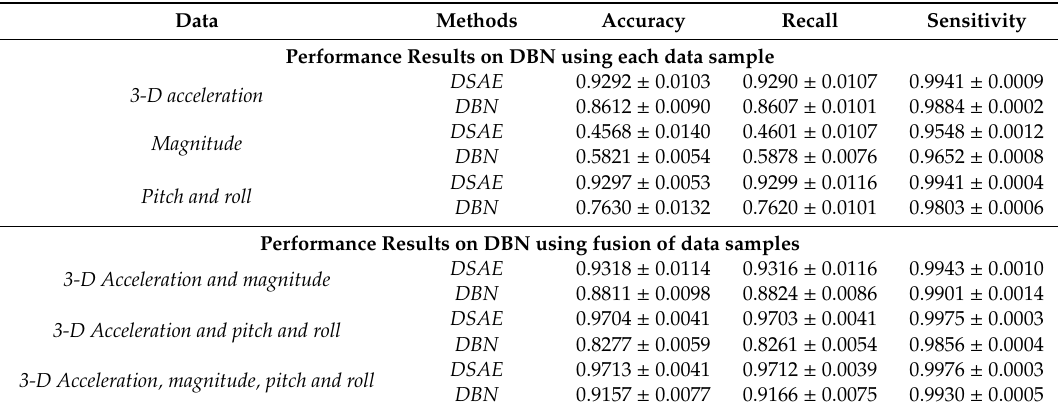
Table 6. Comparison with deep belief networks